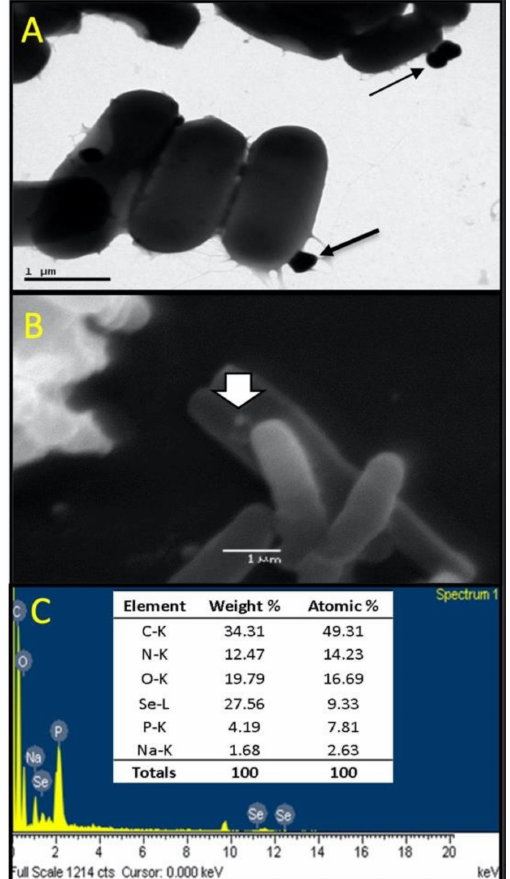
Figure 2. LABS14-Se 0 Nps. ( A ) TEM micrograph of LABS14 showing a bacillar morphology bacterium with nanoparticles attached to the cell surface (black arrows); ( B ) SEM micrograph showing a nanoparticle attached to the bacterial surface (white arrow); ( C ) SEM-EDS data confirmation of the presence of Se in the nanoparticles (Se 0